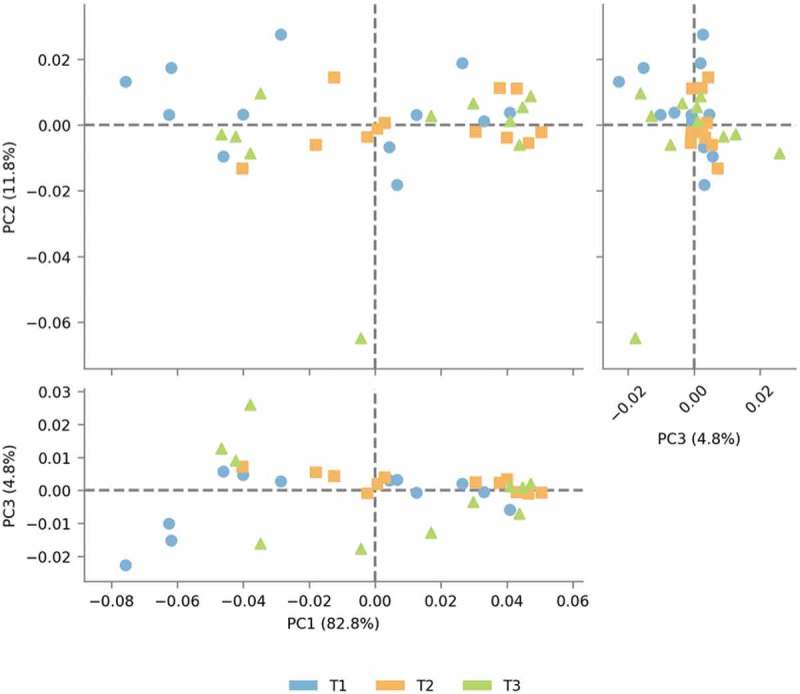
Principal coordinate analysis (PCoA) using STAMP v2.1.3 of predicted functional metagenomes between Time points T1, T2 and T3.